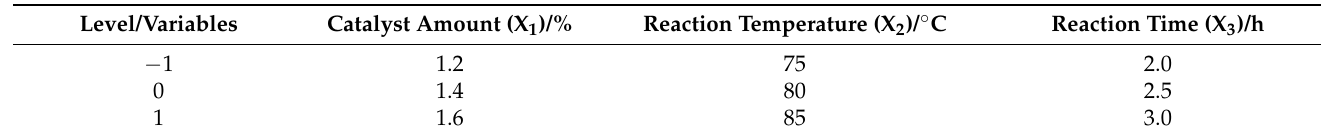
Table 3. The levels of independent variables used for RSM.